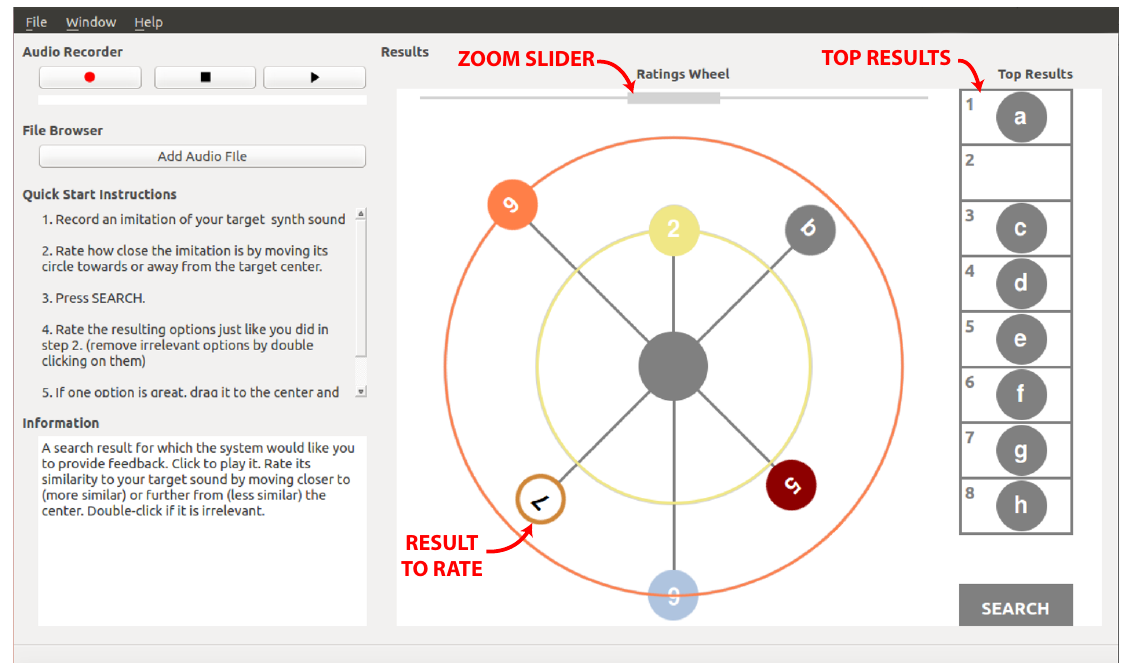
Figure 9. SynthAssist: A new way of programming a music synthesizer. The user starts by recording or uploading a sound similar to what is desired. The interface explores the settings of the synthesizer and returns settings most similar to the example along different dimensions. Each suggestion is represented by one of the colored circles. When a user clicks or moves a suggestion, the synthesizer sound changes. Users rate how similar suggestions are to their target by moving them closer to or farther from the center. If a suggestion is irrelevant, the user can inform SynthAssist and remove it from the screen by double clicking on it. Based on this feedback from the user, the system refines its model of the desired sound and suggests more settings. Dragging a suggestion to the center of the circle indicates this is the desired sound and terminates the interaction. Figure created by the